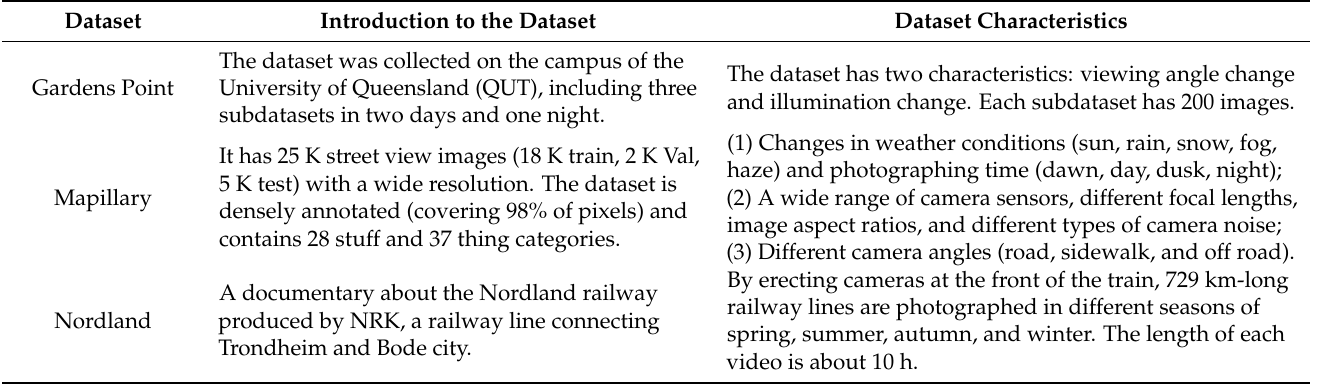
Table 3. Dataset